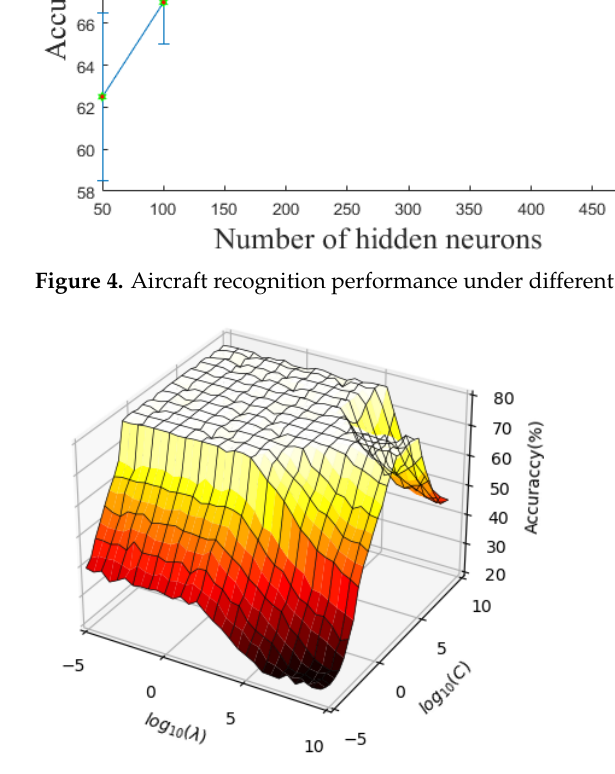
Figure 5. Aircraft recognition performance under different combinations of C and λ